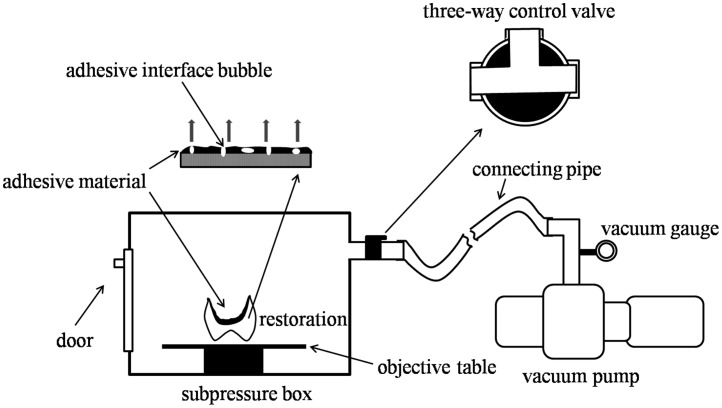
The schematic diagram of the subpressure infiltration technique.